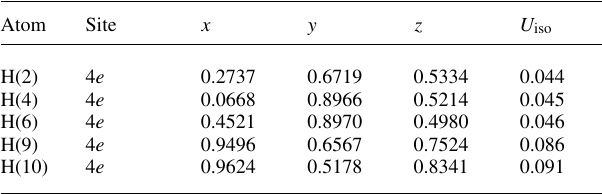
Table 2. Atomic coordinates and displacement parameters (in Å 2 )